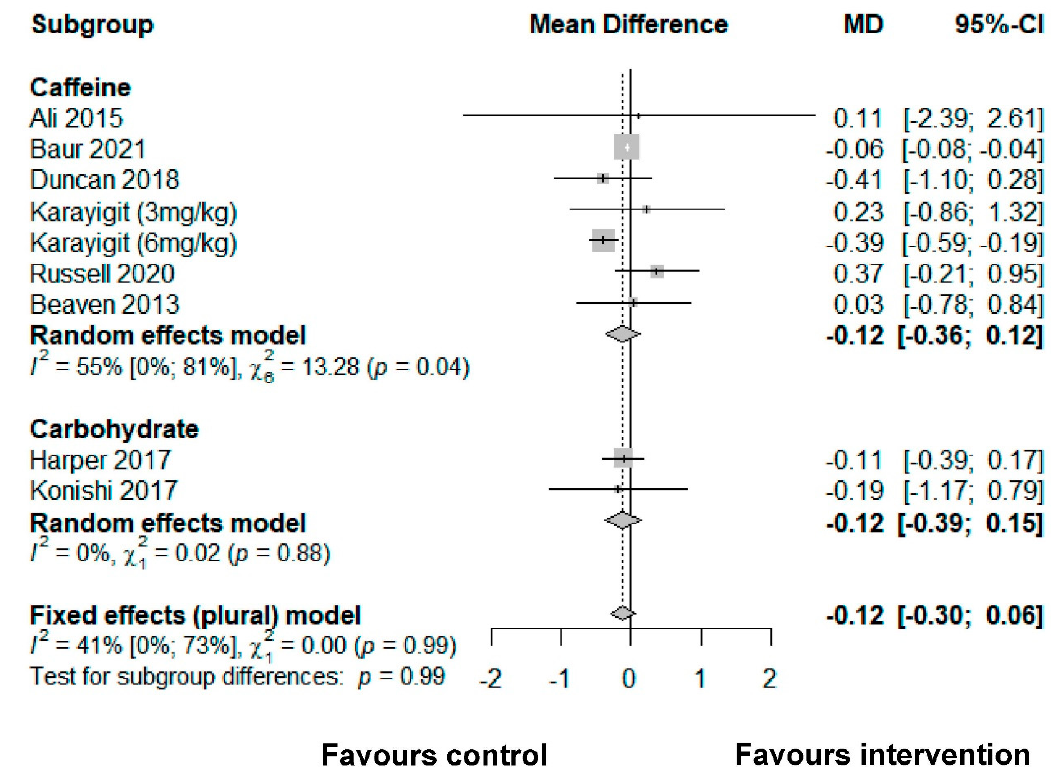
Figure 2. Study quality assessment using an adapted version of the Downs and Black checklist [49].